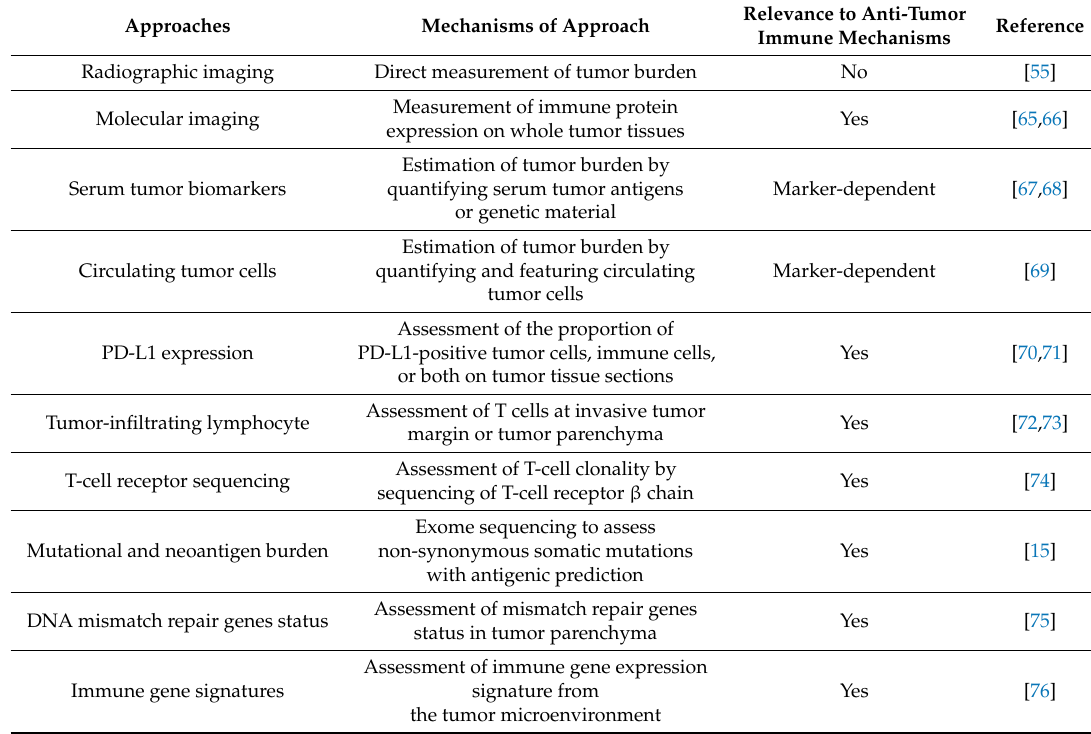
Table 1. Strategies under development for evaluation of immune checkpoint blockade